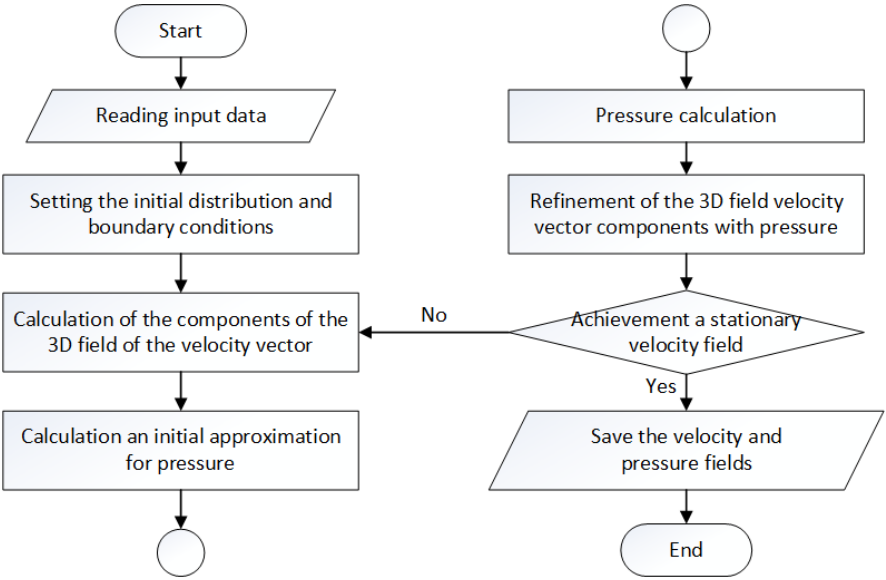
Figure 8. The software module flow